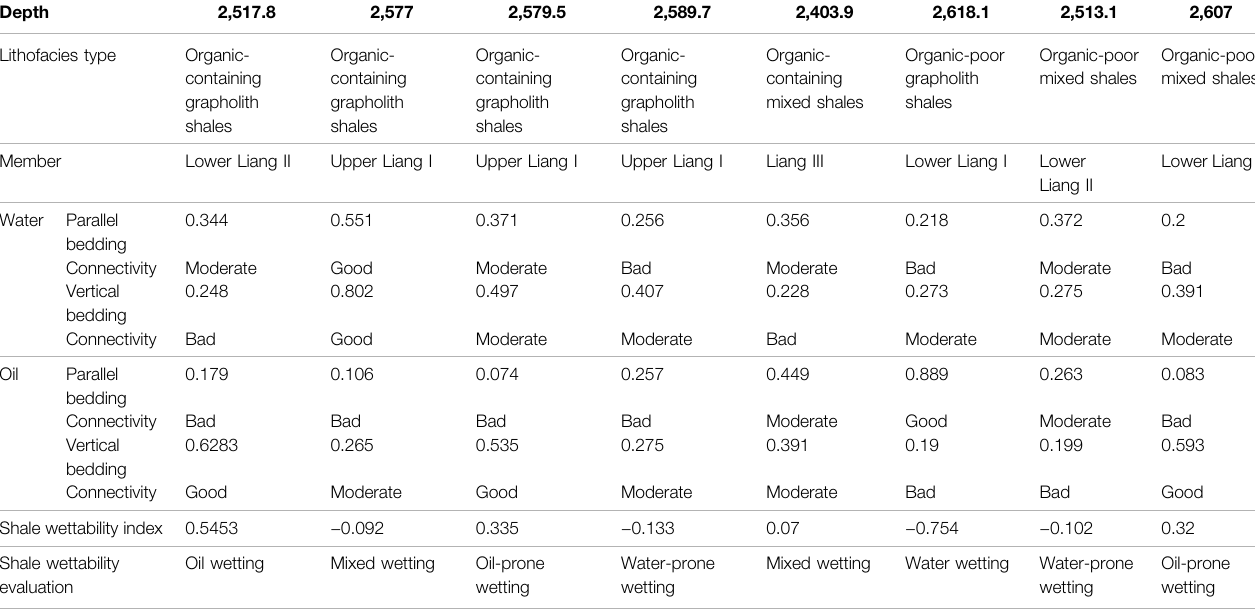
TABLE 8 | Connectivity and wettability evaluation of organic-rich grapholith shales and organic-rich mixed